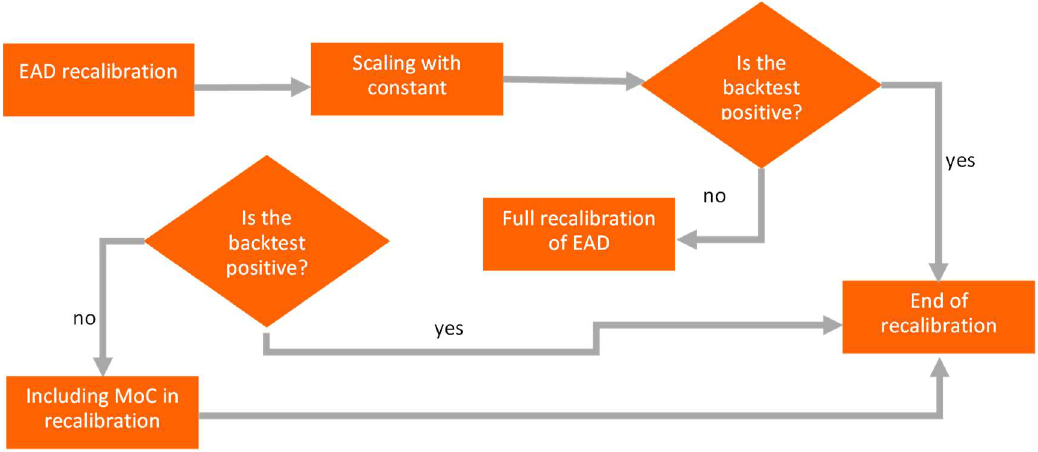
Figure 5. EAD model recalibration scheme . Source: own elaboration.